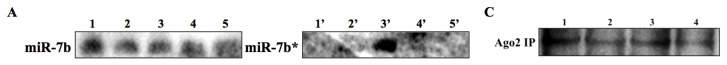
Changed expression levels of miR-7b and miR-7b* after transfection with multi-transcript artificial targets. (A) 24 h after transfection of miRNA artificial targets (1 and 1′. null, 2 and 2′. empty vector, 3 and 3′. miR-7b*, 4 and 4′. miR-7b* mutation I, 5 and 5′. miR-7b* mutation II), AtT-20 total RNA was extracted and analyzed by northern blotting using probes specific for miR-7b and miR-7b*, respectively. Lane 3′ shows that miR-7b* expression was significantly increased following transfection of the miR-7b* artificial target. In contrast, miR-7b expression was similar in non-transfected and miR-7b* artificial targets transfected samples; (B) Twenty-four hours after various artificial targets (1 and 1′. null, 2 and 2′. empty vector, 3 and 3′. miR-7b, 4 and 4′. miR-7b*, 5 and 5′. miR-7b* mutation I, 6 and 6′. miR-7b* mutation II) were transfected, miR-7b (left) and miR-7b* (right) expression levels were analyzed by qRT-PCR. miRNA expression levels were normalize to U6. Fold changes are expressed versus empty target of each (2 or 2′); (C) Twenty-four hours after various artificial targets (1 and 1′. empty vector, 2 and 2′. miR-7b*, 3 and 3′. miR-7b* mutation I, 4 and 4′. miR-7b* mutation II) were transfected, AtT-20 lysates were immunoprecipitated (IP) using anti-Ago2 antibody. IPs were analyzed by immunoblotting with the same anti-Ago2 antibody (upper panel). Co-immunoprecipitated RNA was extracted and analyzed by qRT-PCR (lower panel). Fold changes are expressed versus the empty target for each (1 or 1′). Error bars in graphs indicate standard deviations; p-values are also indicated.